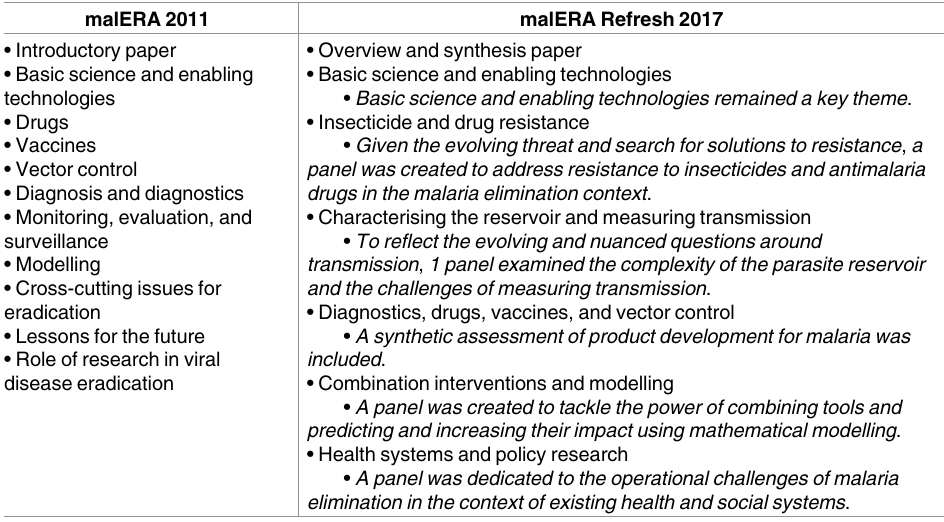
Table 2. Using the themes from the first malERA process as a starting point, malERA Refreshwas organised by researchthemesthat are relevantfor malariaelimination and eradication and reflect cur- rent hypotheses and new